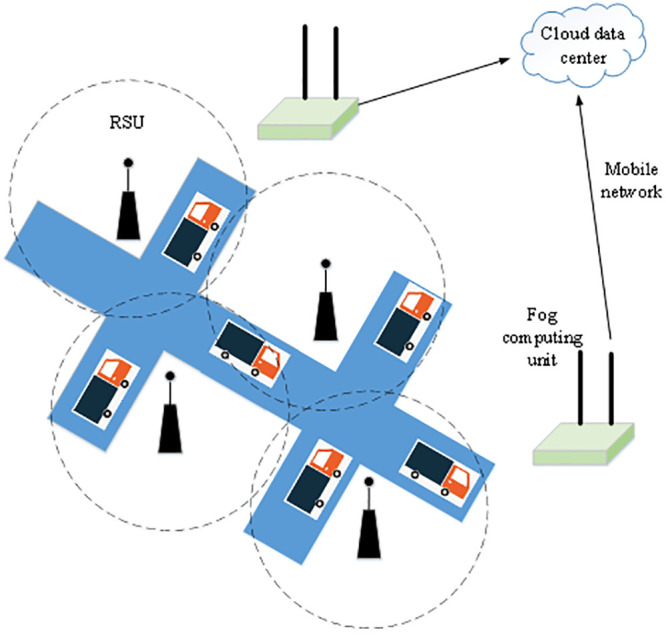
ND of FG-based freight ILP model.